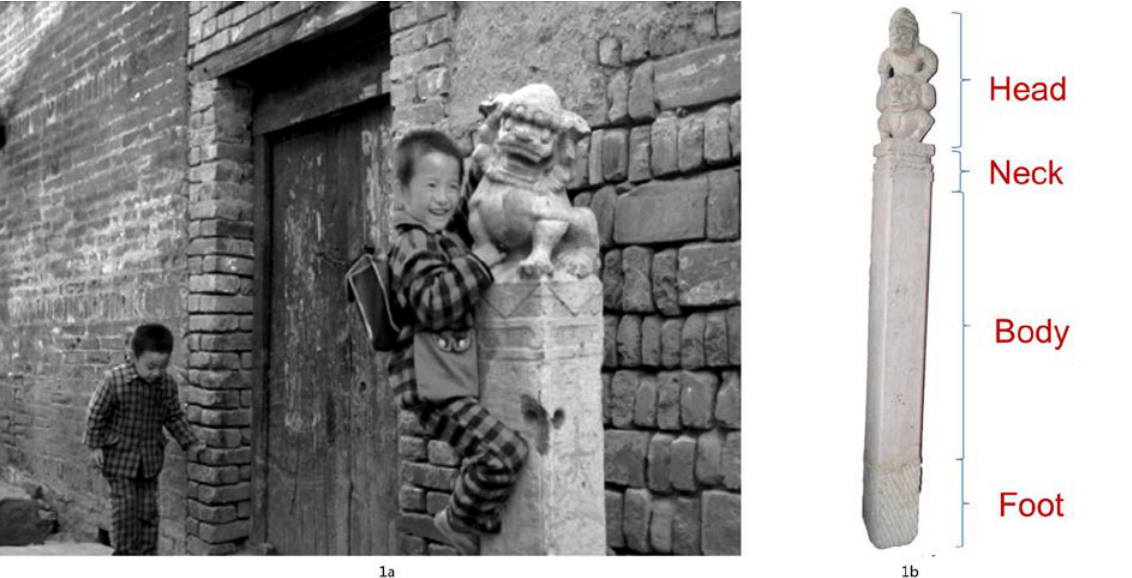
Figure 1. a) Horse hitching stone posts found originally before 1992. Photographed by Wugong Hu; b) Structure of horse hitching stone